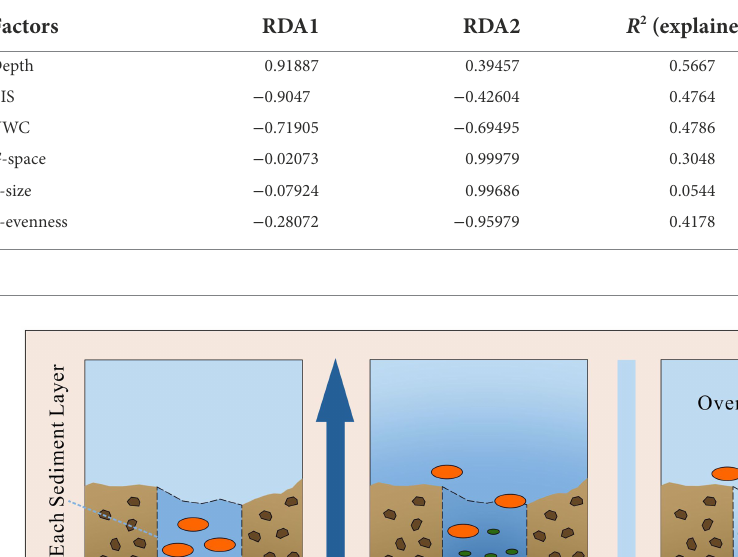
TABLE 2 Results of RDA analysis (detailed information).